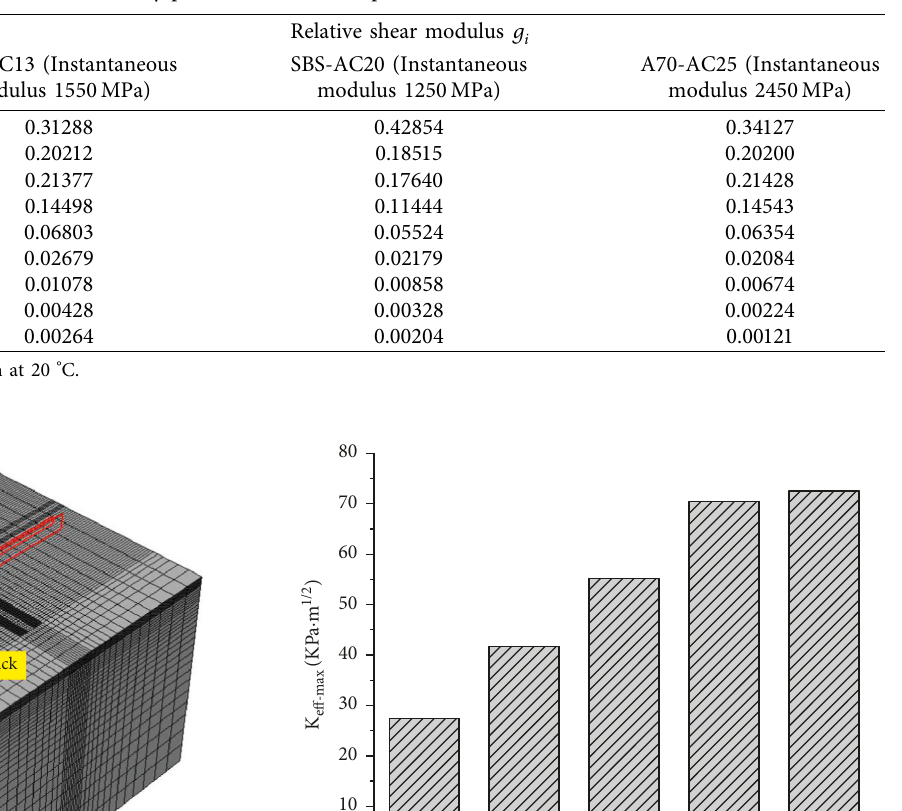
Table 2: Prony parameters of each asphalt mixture.